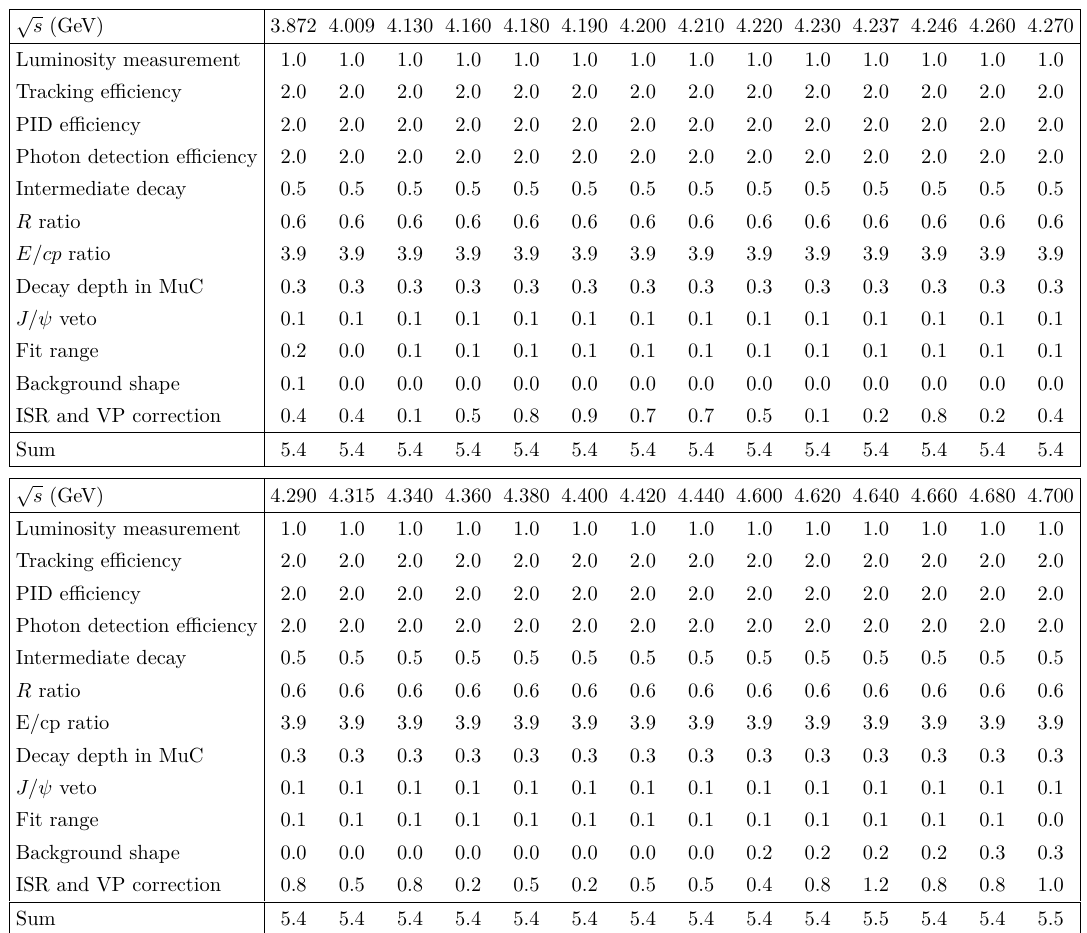
Table 4 . The relative systematic uncertainties (%) for the process e + e − → ηπ + π − .